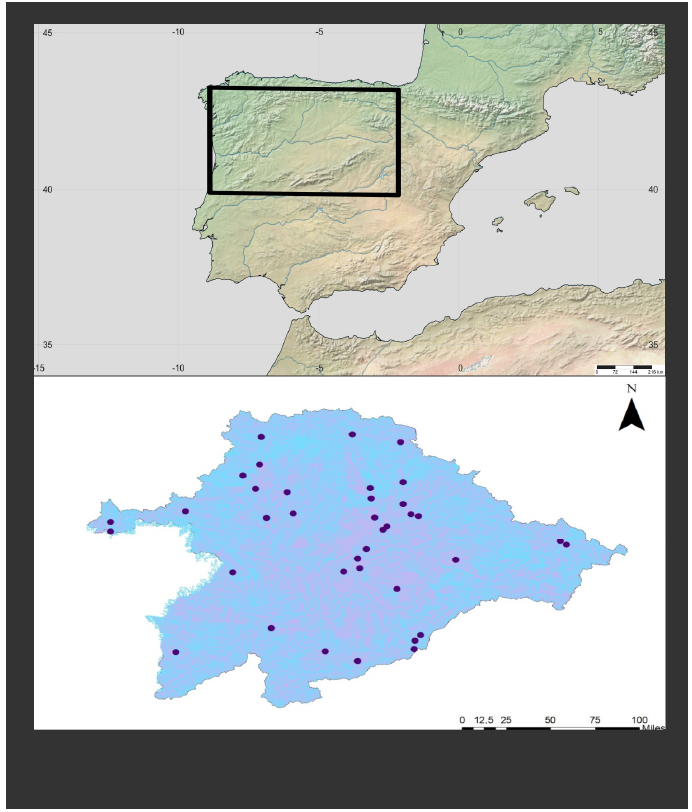
Figure 1. Map of the Duero River Basin within the Iberian Peninsula, showing the points corresponding to the hydrographic stations used in this study.